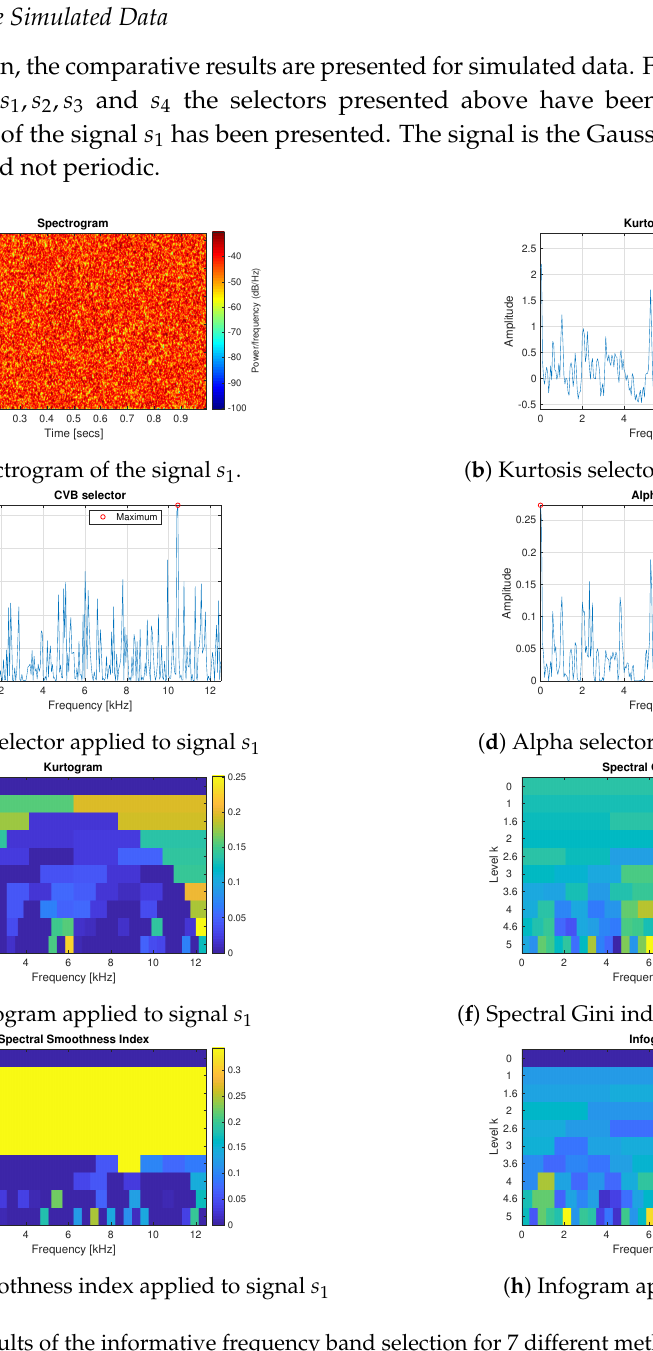
Figure 2. Results of the informative frequency band selection for 7 different methods for the signal s 1